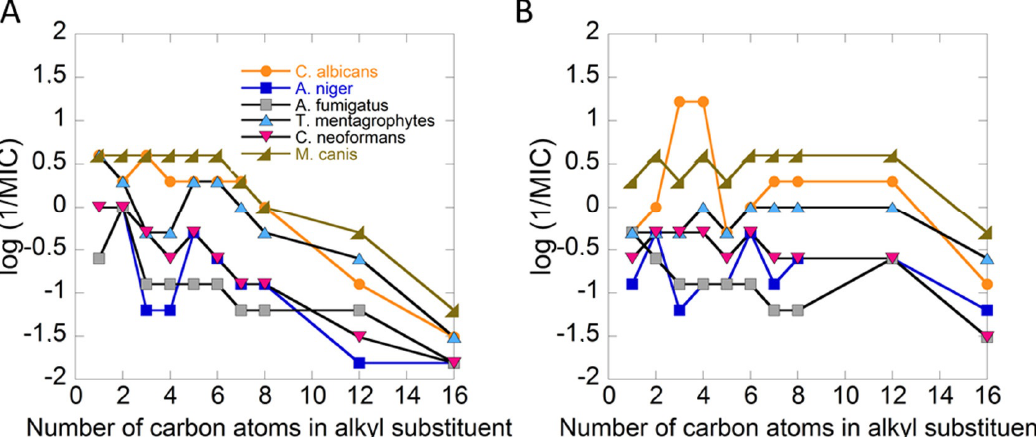
Figure 4. The relationship between the activity (in the log (1/MIC) of the salts against fungal species and the number of carbon atoms in the alkyl chain (( A ): the salts 3a-j , ( B ): the salts 4a-j ).